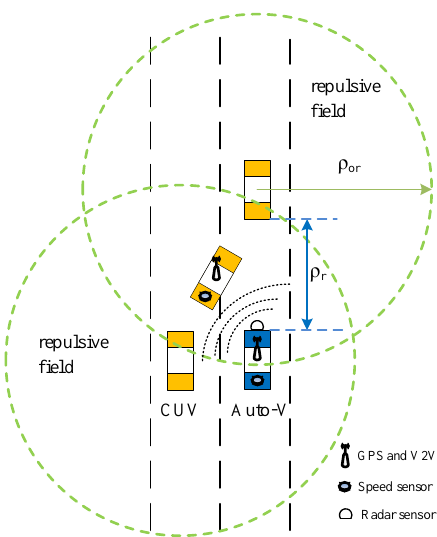
Figure 6. A repulsive field centered on a lane change vehicle.